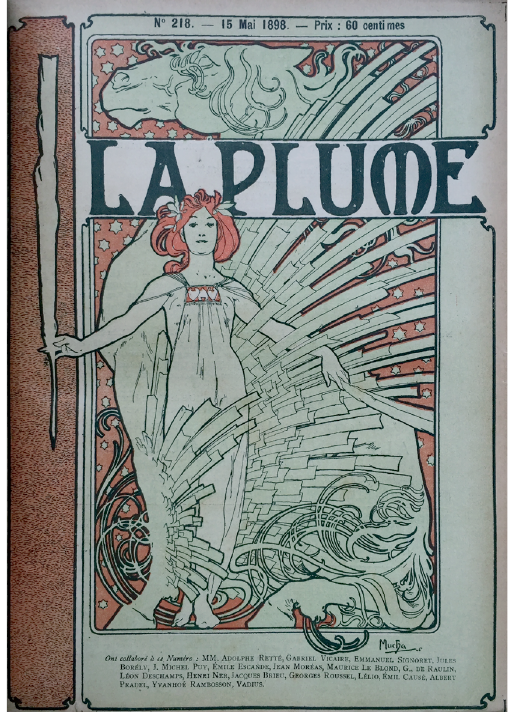
Fig. 4 Alphonse Mucha, La Plume (15 May 1898), front